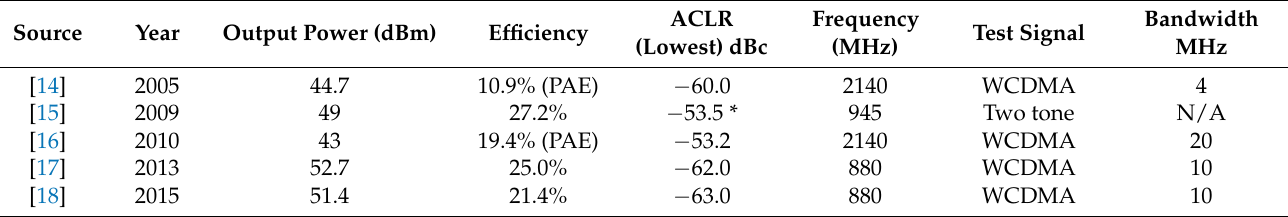
Table 1. Feedforward method